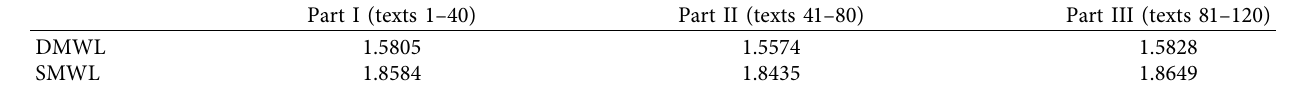
Table 2: Dynamic and static mean word length of the three parts of DRC.